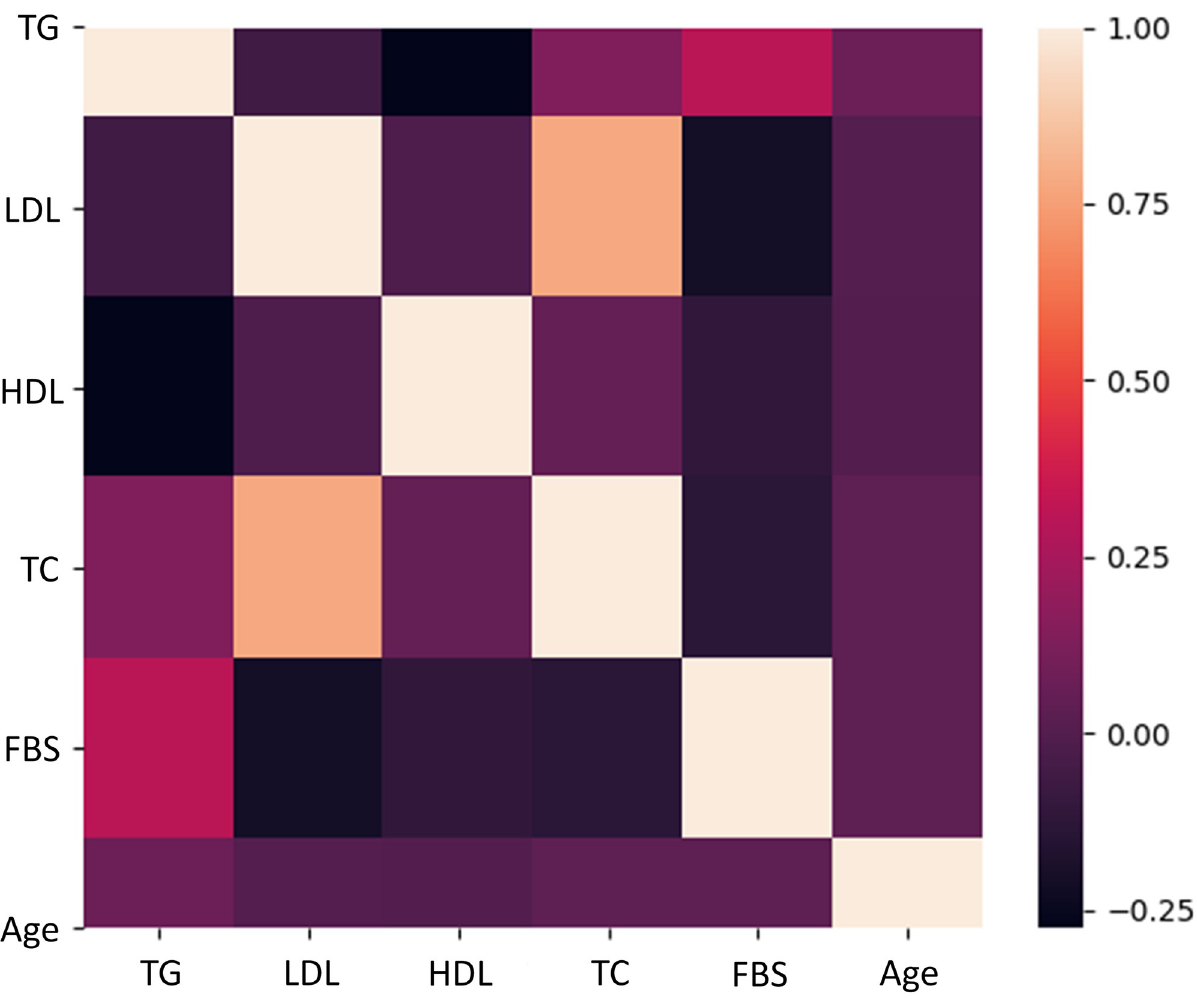
Fig 4. A heat map shows the associations between Fasting Blood Sugar (FBS), age and lipid parameters. Color scale is displayed at the right corner. A positive correlation is indicated by light colors (i.e. yellow), while a negative relationship is indicated by dark colors (i.e., dark purple). Triglyceride (TG) is moderately associated with FBS, needless to say that there is a strong correlation between low-density lipoprotein (LDL) and TC.